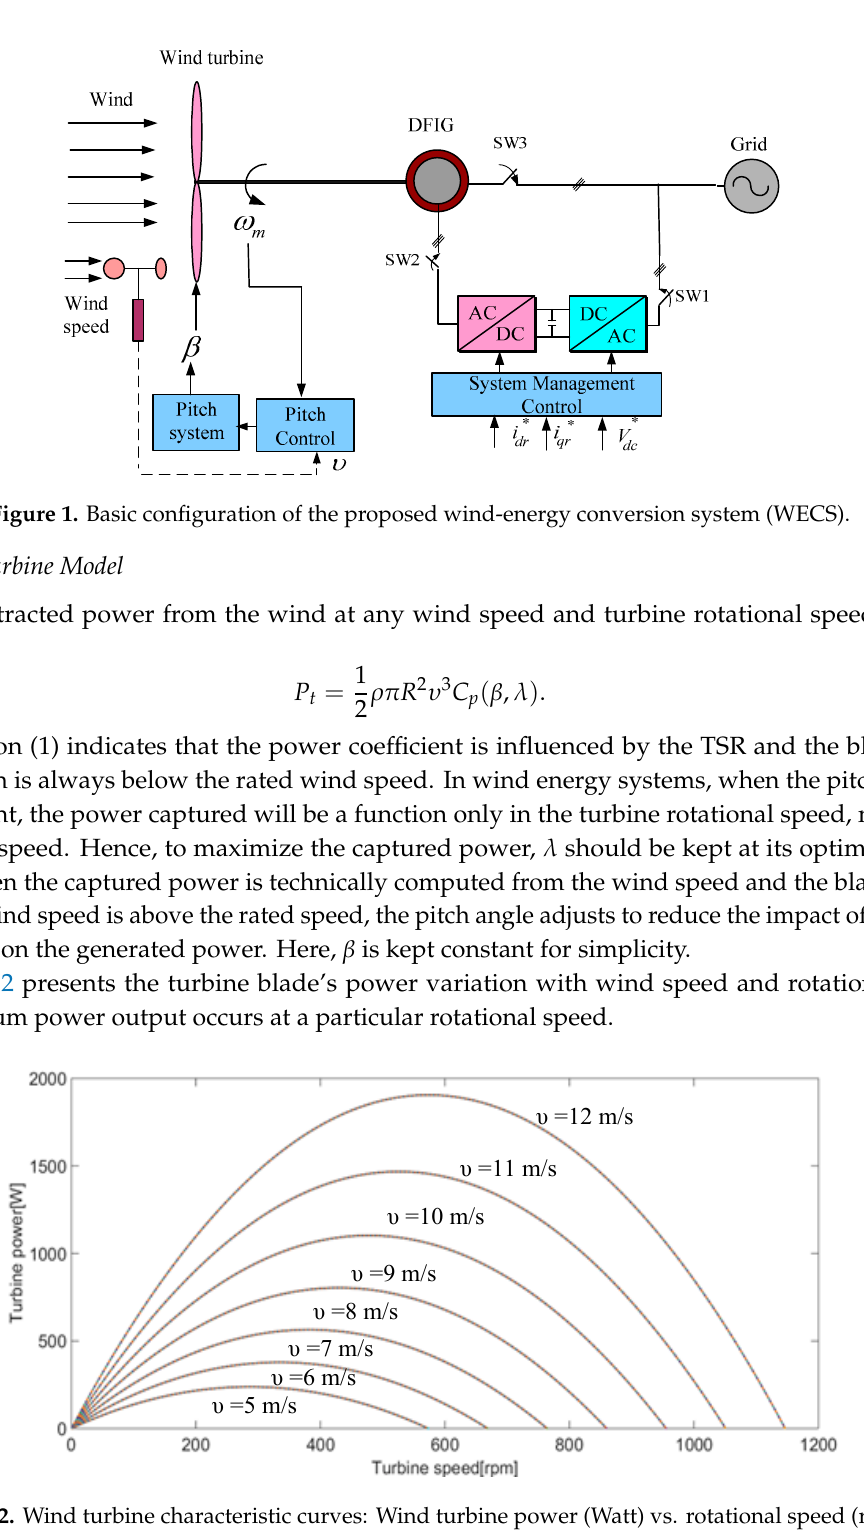
Figure 2. Wind turbine characteristic curves: Wind turbine power (Watt) vs. rotational speed (rpm).